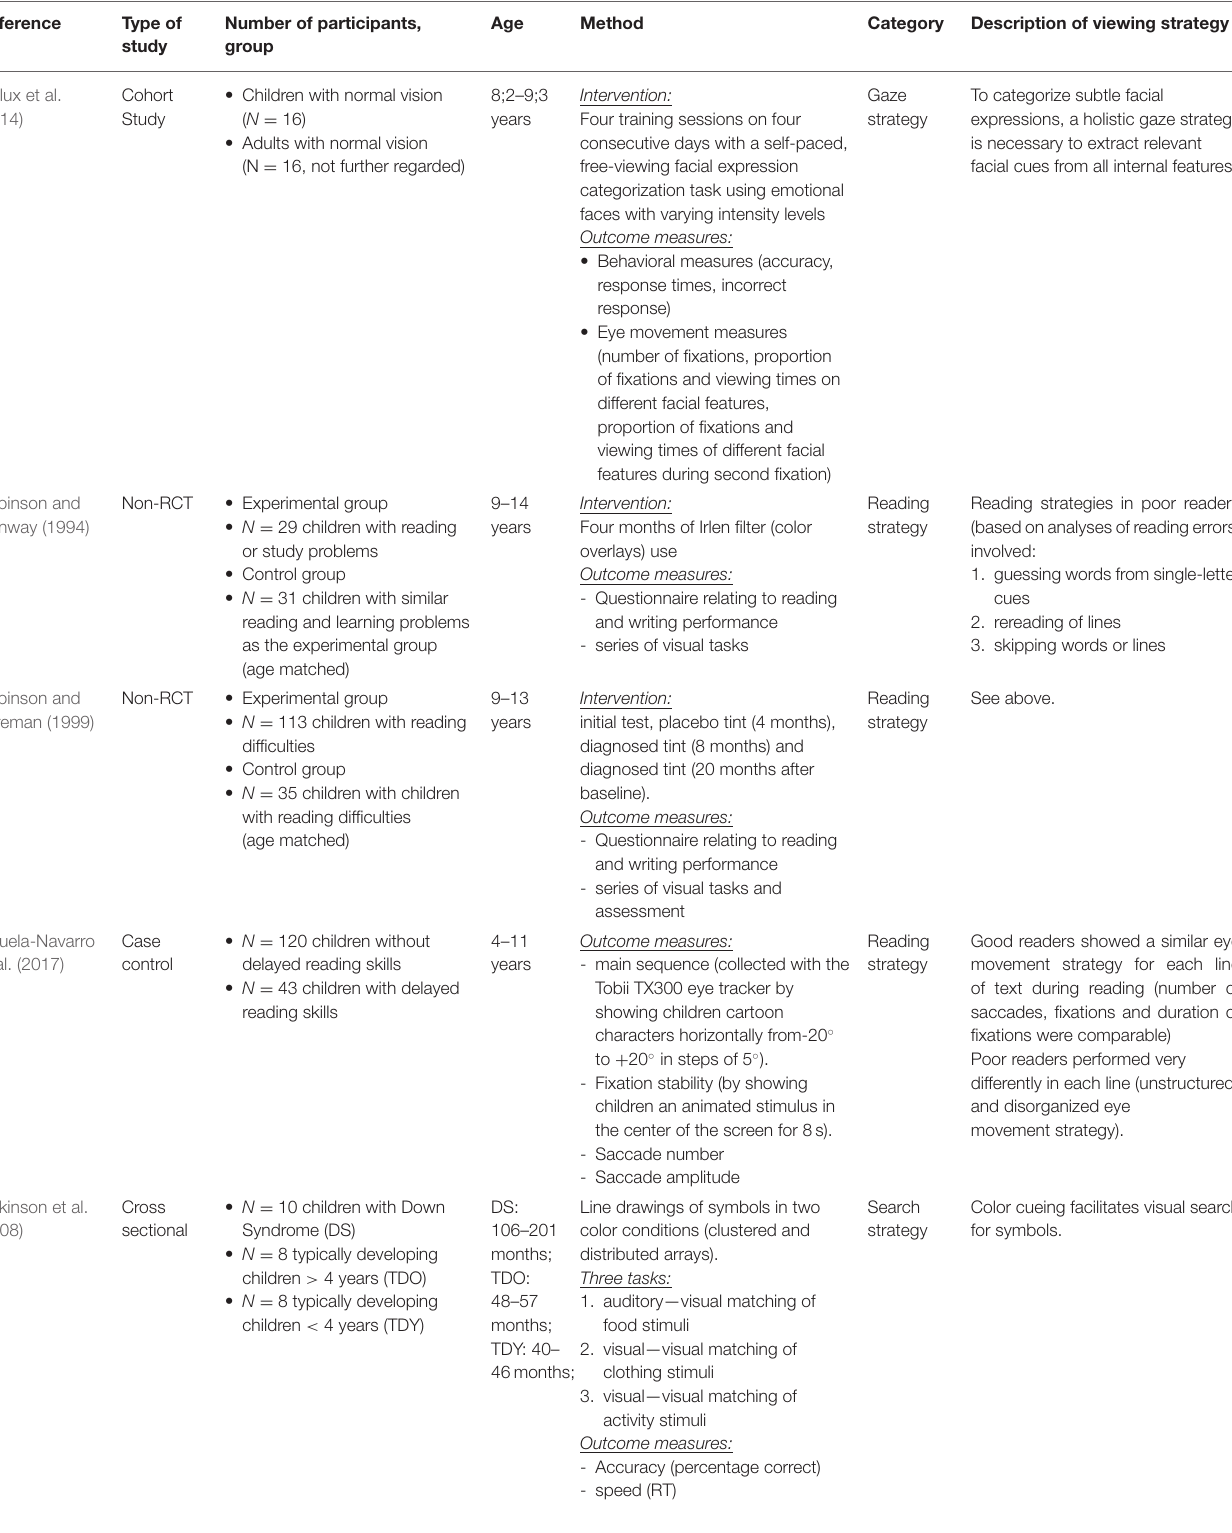
TABLE 4 | Study characteristics and descriptions of viewing